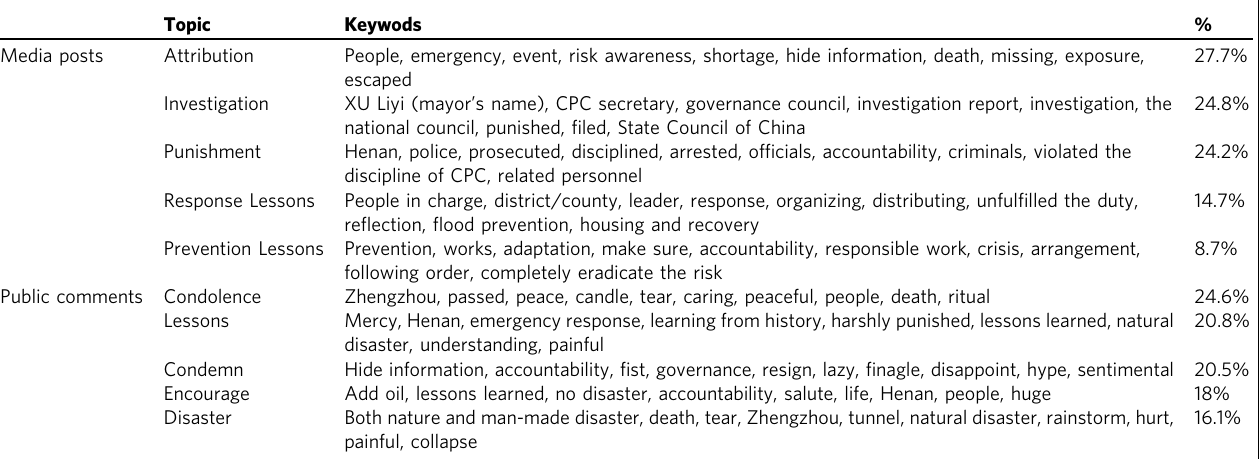
Table 2 Topics and keywords during the crisis learning period (01/21/2022 – 03/31/2022). Topic Keywods Media posts